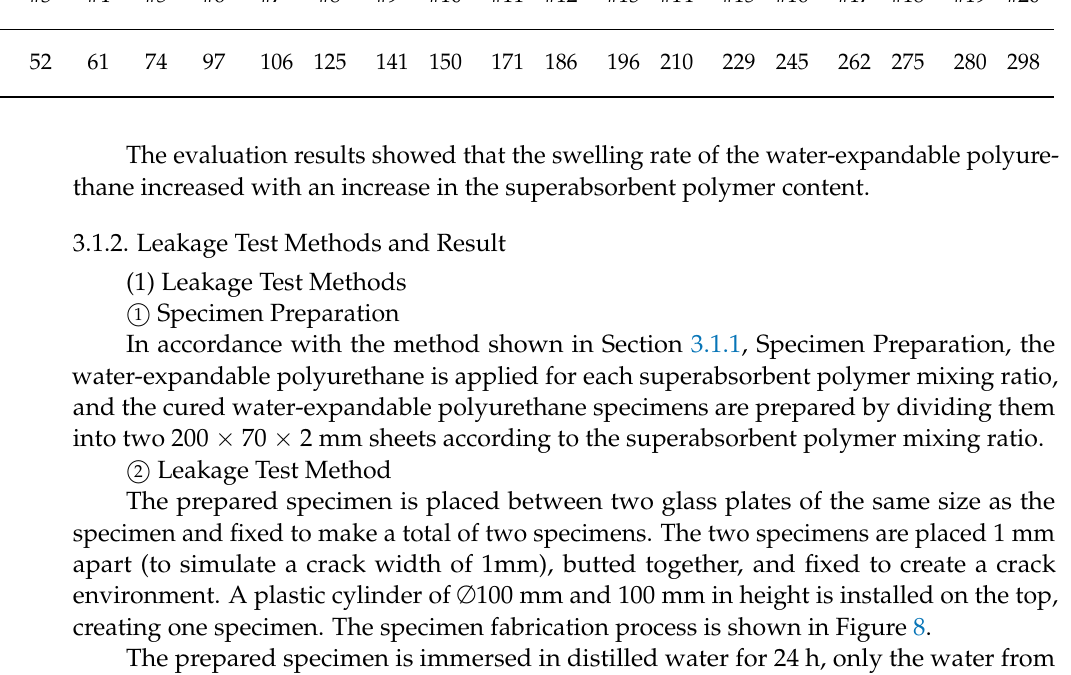
Figure 7. The swelling rate test status: ( a ) Initial volume measurement; ( b ) Volume measurement after expansion.